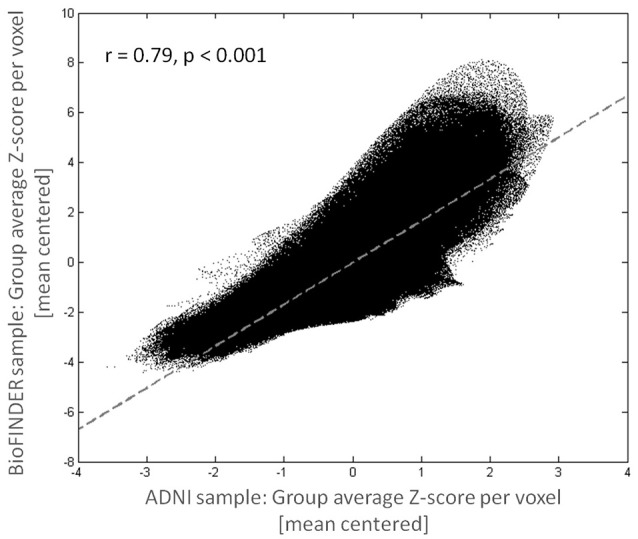
Consistency of tau deposition pattern across cohorts. Mean voxelwise cortical Z-scores for the BioFINDER and ADNI sample were highly correlated.